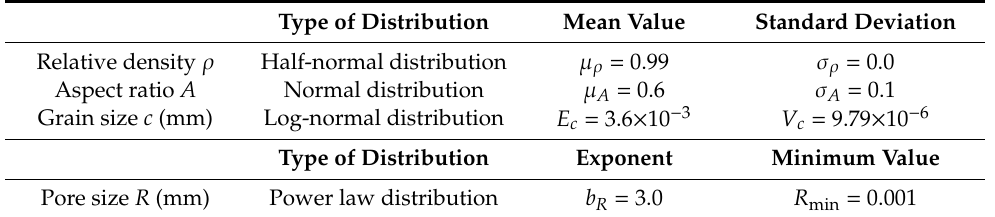
Table 2. Distribution characteristics of the microstructure. The mean value and standard deviation of the half-normal distribution are those before half-folding of the normal distribution.